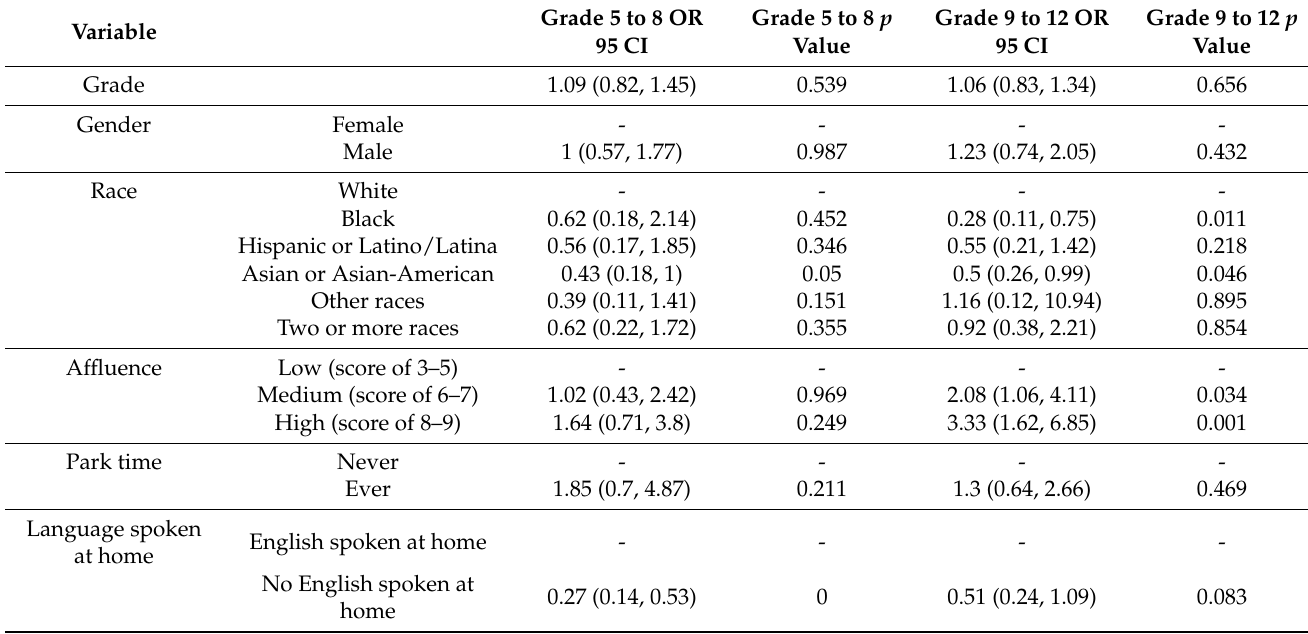
Table 5. Characteristics Associated with ever having participated in organized